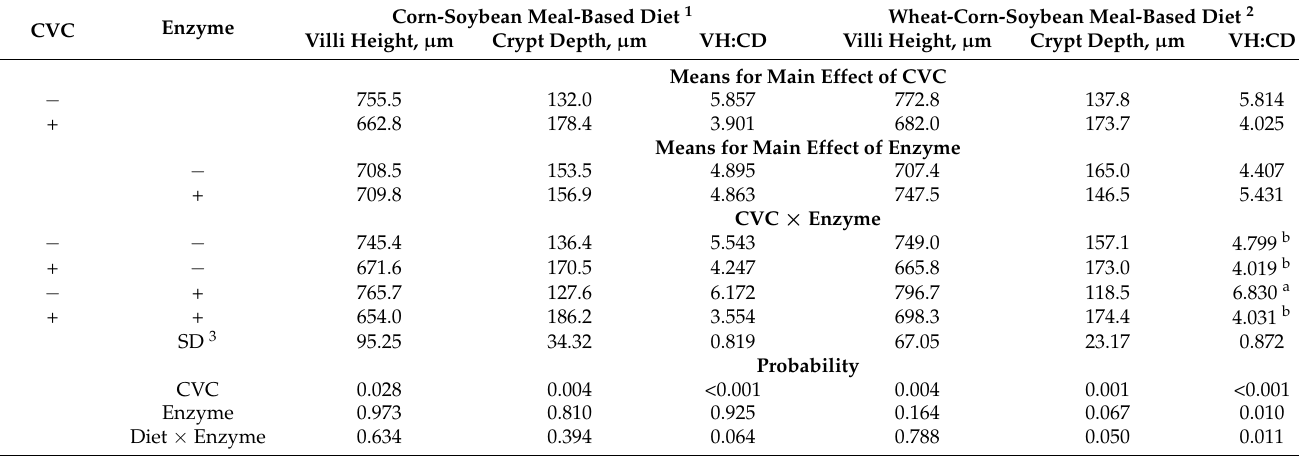
Table 9. Main and simple effects of coccidia vaccine challenge (CVC) and exogenous enzyme supplementation on ileal villi height (VH), crypt depth (CD), and height-to-crypt-depth ratio (VH:CD) in 21-day old broiler chickens (7-day post-challenge).